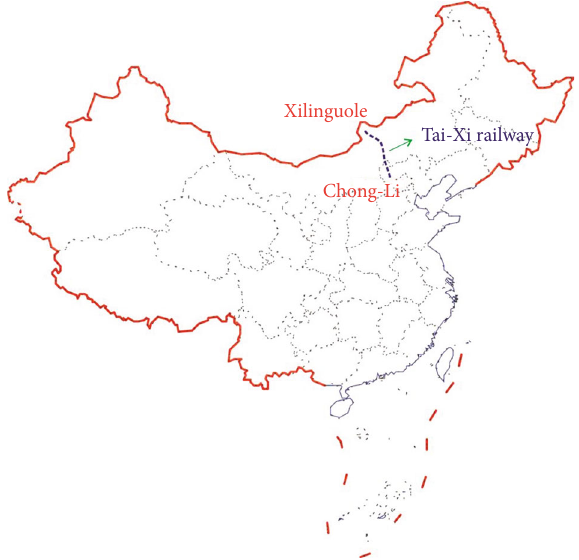
Figure 1: Panoramic route map of the Tai-Xi Railway.